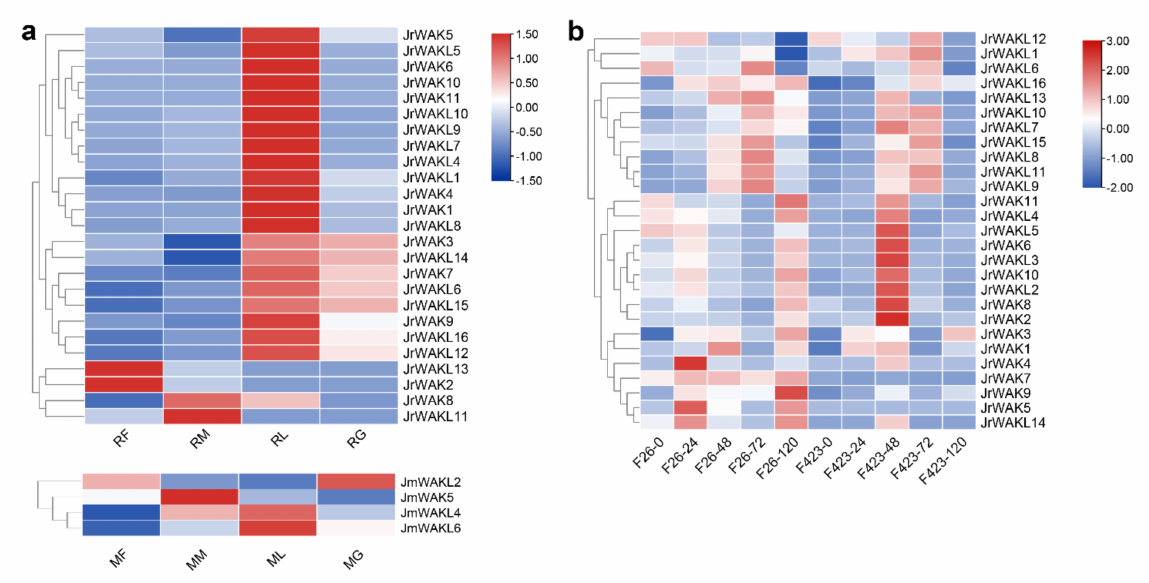
Figure 6. Expression patterns of WAK/WAKLs in J. regia and J. mandshurica . ( a ) Expression patterns of identified WAK/WAKLs in female flowers, male flowers, leaves and green pericarp of two Juglans species; RF, female flowers of J. regia ; RM, male flowers of J. regia ; RL, leaves of J. regia ; RG, green pericarp of J. regia ; MF, female flowers of J. mandshurica ; MM, male flowers of J. mandshurica ; ML, leaves of J. mandshurica ; MG, green pericarp of J. mandshurica ; ( b ) Expression patterns of identified WAK/WAKL in J. regia under biotic stress. F26 indicated anthracnose-resistant varieties, F423 indicated anthracnose-susceptible varieties. The number after ‘-’ represented the time after infection (unit: hour). The colored scale reflects gene expression